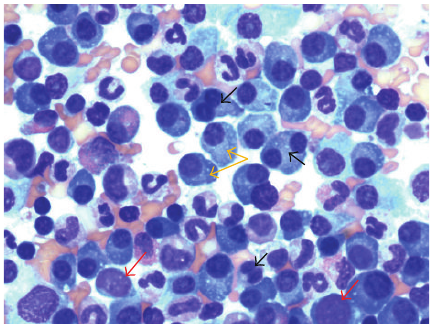
Figure 1: Wright-Giemsa stain of the bone marrow aspirate demon- strating more than 50% of morphologically variable plasma cells including binucleate forms (black arrows), mature plasma cells with large basophilic cytoplasm, eccentric nucleus with perinuclear halo and clock face chromatin (orange arrows), and immature cells with high nuclear-cytoplasm ratio and dispersed chromatin (red arrows).